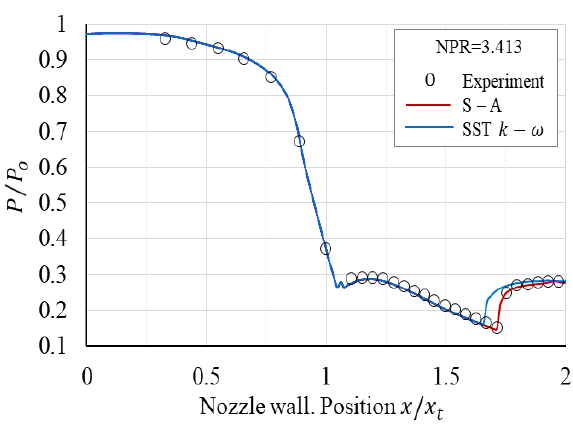
Figure 4. Wall Pressure for NPR=3.413.Source: Hunter experiment [37]. Source: Simulation,